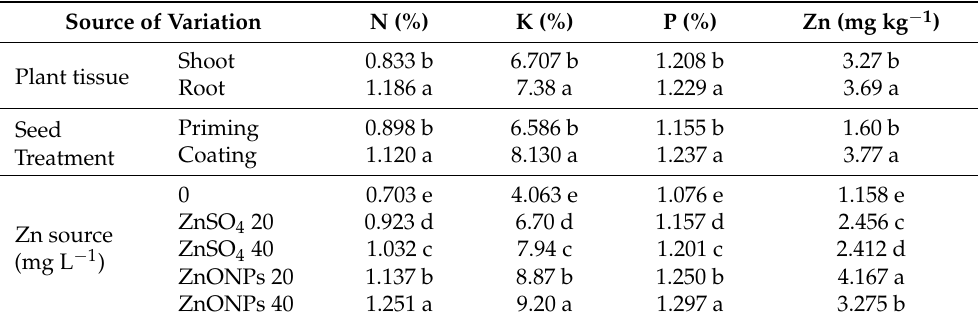
Table 4. Effect of seed treatments with different concentrations of ZnONPs on plant nutrient status of fodder maize (variety J-1006) grown under field